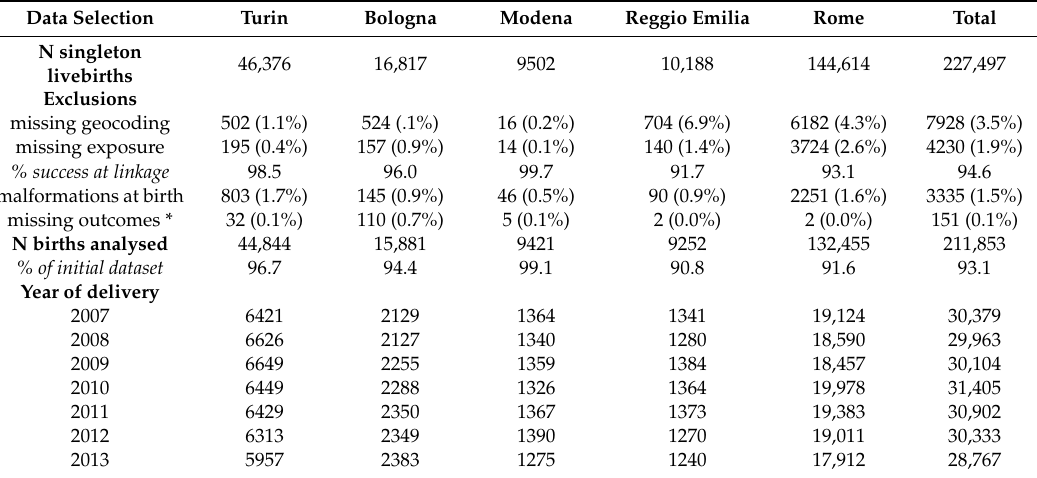
Table 1. Selection of the birth cohorts